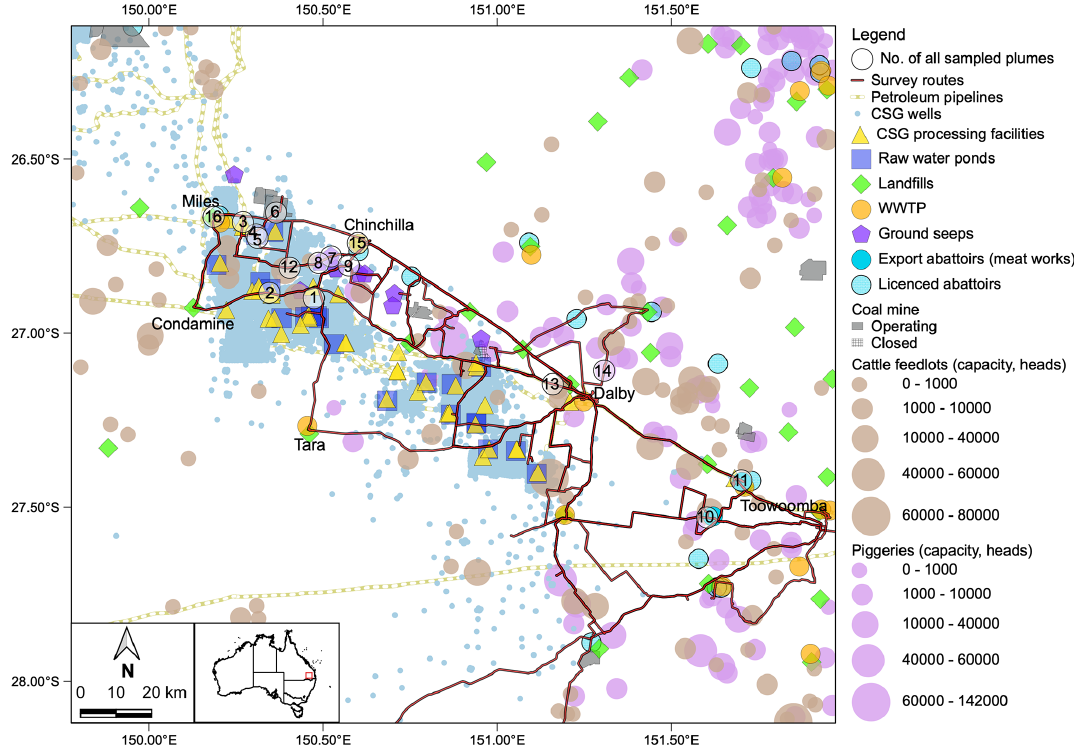
Figure 1. Map of the study area with survey routes and potential CH 4 sources. Inset map shows the location in south-eastern Queensland (inset map data: Australian Government, 2020, Administrative Boundaries © Geoscape Australia). The positions of the sampled CH 4 plumes are numbered 1 through